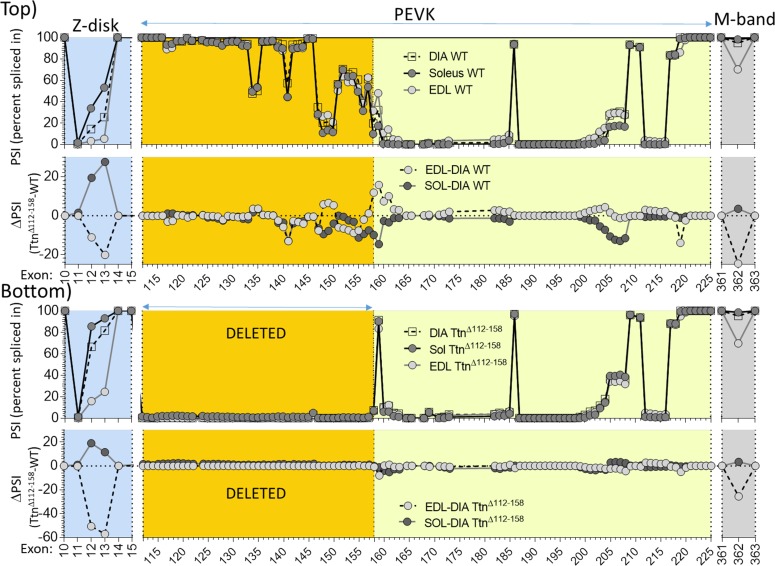
Titin expression analysis in diaphragm, EDL and soleus muscle, in part of Z-disk, complete PEVK and part of M-band regions.Top: superimposed results of WT (top) and PSI difference between EDL and diaphragm and between soleus and diaphragm (bottom). Bottom: superimposed results of Ttn∆112-158 mice (top) and PSI difference between EDL and Diaphragm and between soleus and diaphragm (bottom).